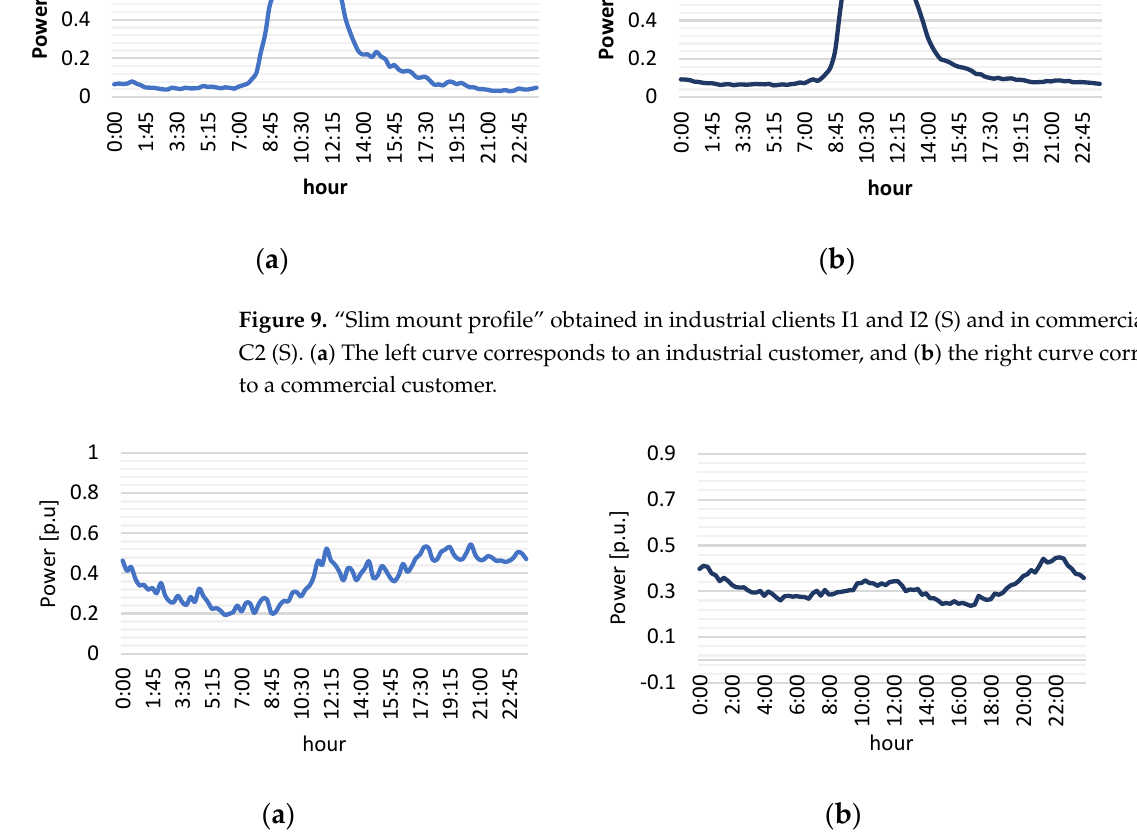
Figure 10. “W-type profile” obtained in industrial clients I1 (D) and commercial clients C2 (D). ( a ) The left curve corresponds to an industrial customer, and ( b ) the right curve corresponds to a commercial customer.